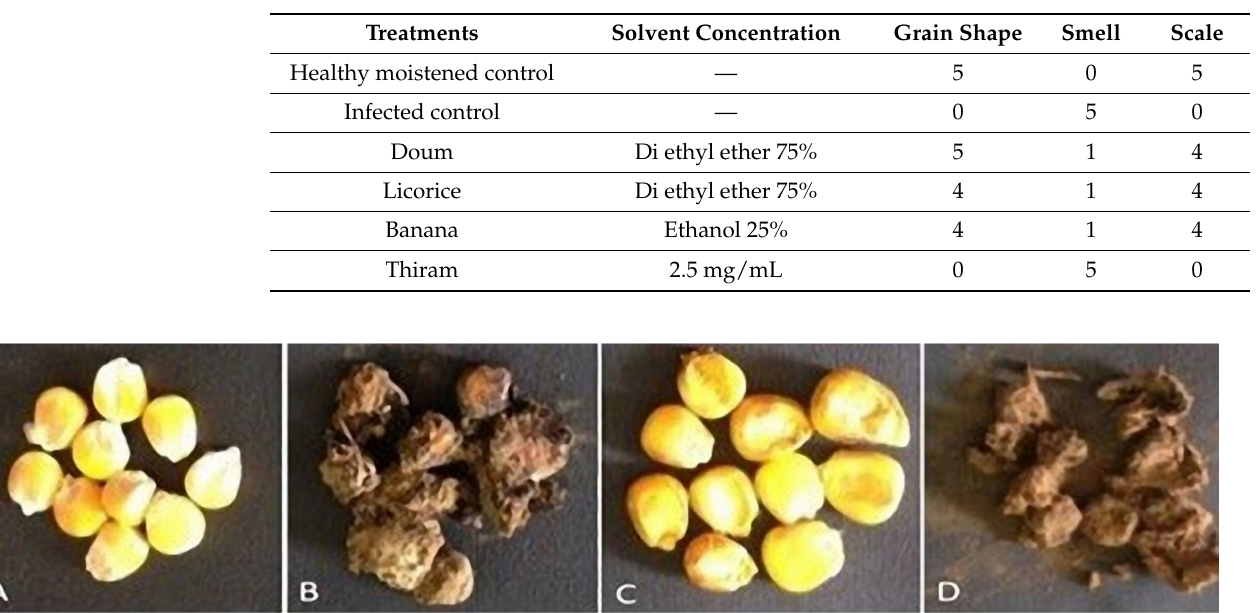
Table 5. Effect of the tested extracts and fungicide on grain appearance and smell.